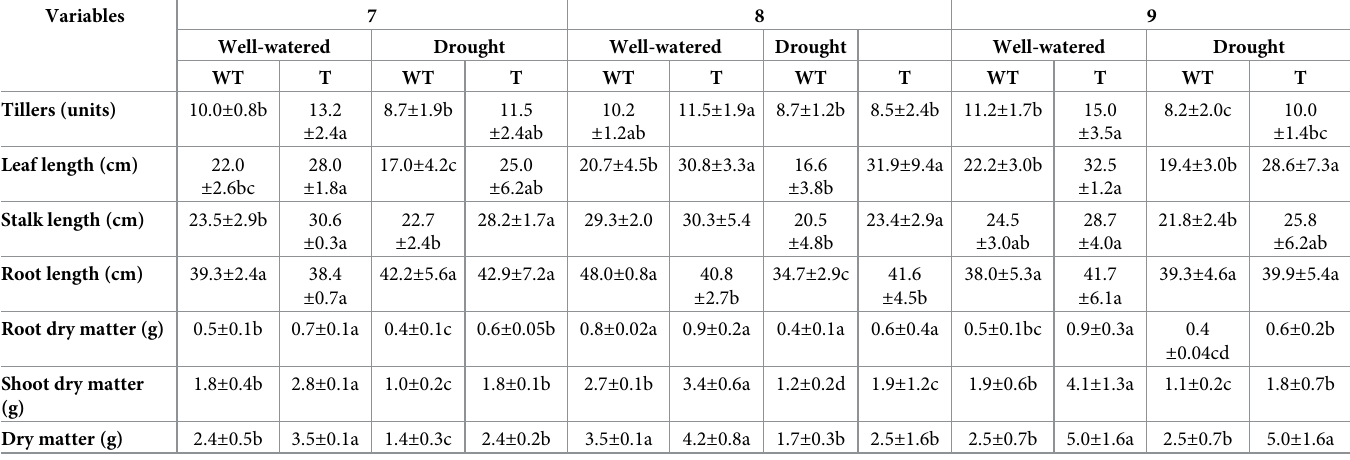
The values are mean ± SE (n = 4). The letters on the same lines indicate significant difference by Student’s t-test (P < 0.05) within the same event.